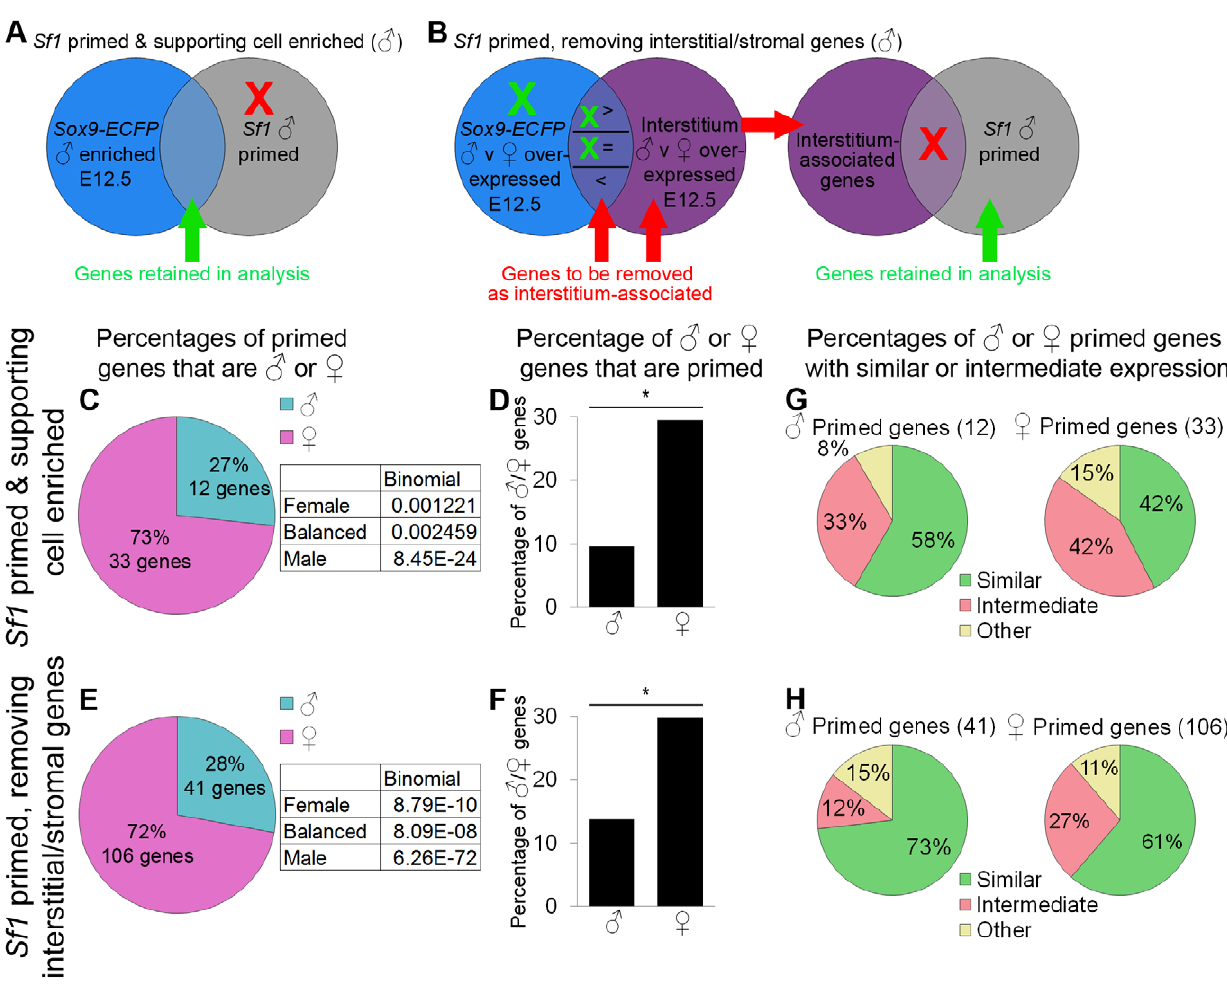
Figure 6. Data from sorted Sf1-EGFP cells also supported female-biased priming for supporting cells. (A–B) Graphical illustrations of the genes included in our analysis of priming in the Sf1-EGFP data. Because the Sf1 -positive population is a mixture of lineages, we used two methods to identify the primed genes associated with supporting cells. XY cells are illustrated in this example, but the same operations were also performed for XX cells. (A) ‘‘ Sf1 primed and supporting cell enriched’’ genes were both male-primed in the Sf1-EGFP data (comparing E11.0 and E12.5) and lineage- specifically enriched in our XY Sry-EGFP/Sox9-ECFP purified supporting cells at E12.5. Red indicates genes being removed from the analysis, and green indicates genes being retained. (B) For the ‘‘ Sf1 primed, removing interstitial/stromal genes’’, we removed genes associated with the interstitial/ stromal cells at E12.5 (i.e., sexually dimorphic in the interstitium/stroma) from the Sf1-EGFP primed genes. Genes that were expressed sexually dimorphically in both the interstitial/stromal cells and the supporting cells were removed only if expression was higher in the interstitial/stromal cells than in the Sry-EGFP/Sox9-ECFP supporting cells. The Sf1-EGFP primed genes that were enriched in the Sry-EGFP/Sox9-ECFP supporting cells (C, D, and G) and those that were identified by removing interstitial/stromal genes (E, F, and H) were analyzed separately. (C and E) The percentages of primed genes that were male-primed and female-primed. Both methods showed a female bias. The boxes contain the p-values from the binomial test with the expected percentages of the extreme models, and all extreme models could be rejected as having a p-value , 0.05. (D and F) The percentage of male or female genes that were primed showed a significant (*) bias toward the female pathway, as determined by the hypergeometric test (p- value , 0.05). (G and H) However, primed genes in both sexes were predominantly expressed at similar levels in progenitors and E12.5 supporting cells of one sex. While supporting cell progenitors have a female bias, they also express some markers of the male pathway at levels similar to male supporting cells at E12.5. Gene lists and permutation tests are provided in Dataset